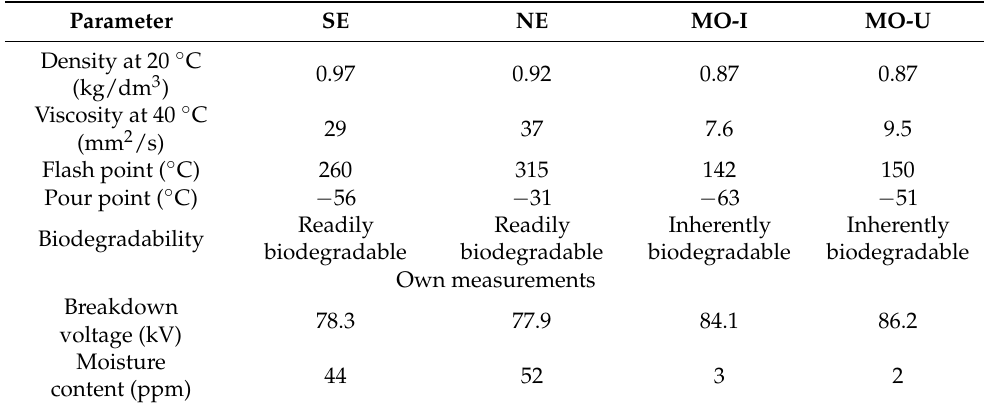
Table 2. Properties of dielectric liquids used in the experiment.